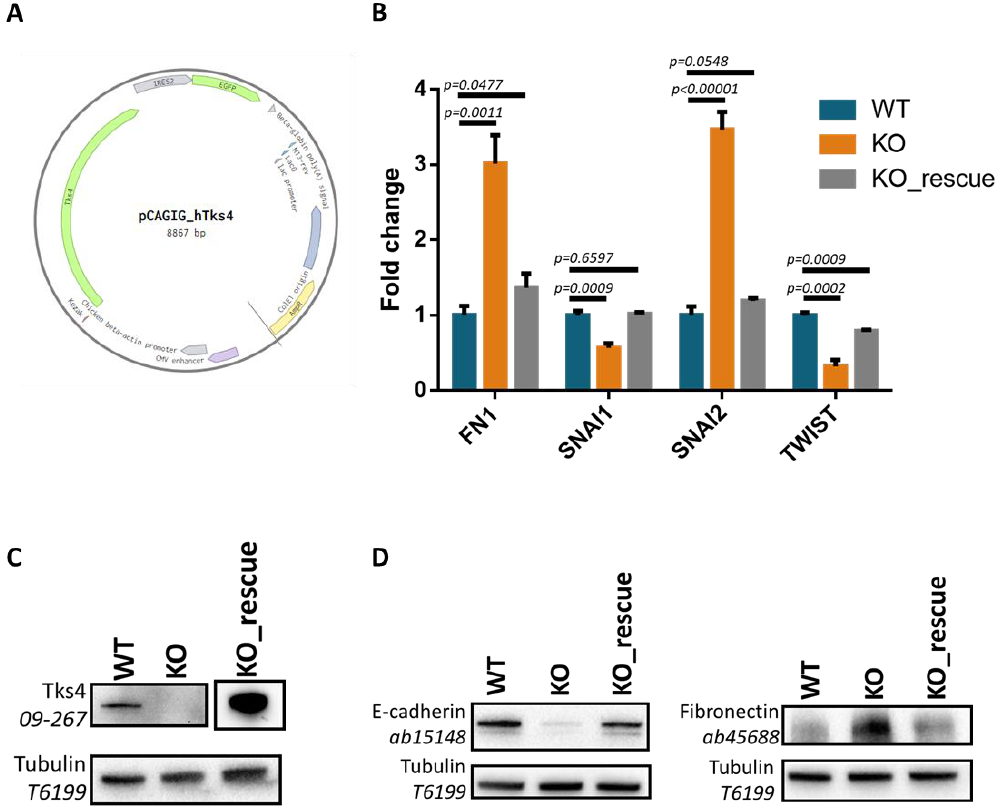
Figure 5. Transfection of Tks4-KO cells with a Tks4 encoding plasmid. ( A ) Tks4 KO cells were transiently transfected with a Tks4 “rescue” expression plasmid. 24 h later, cells were harvested and subjected to qPCR analyses. The expression levels of Snail1 (SNAI1), Snail2 (SNAI2), Twist (TWIST), and fibronectin (FN1) were measured as described in the Materials and Methods. The error bars show the standard deviation, and the statistical analyses were carried out using the unpaired Student’s t-test. ( B ) Schematic diagram of the Tks4-encoding pCAGIG vector. ( C ) Western blot experiments using WT, KO and KO_rescue cell lysates with Tks4 antibody ( D ) Western blot experiments using WT, KO and KO_rescue cell lysates with E-cadherin and Fibronectin